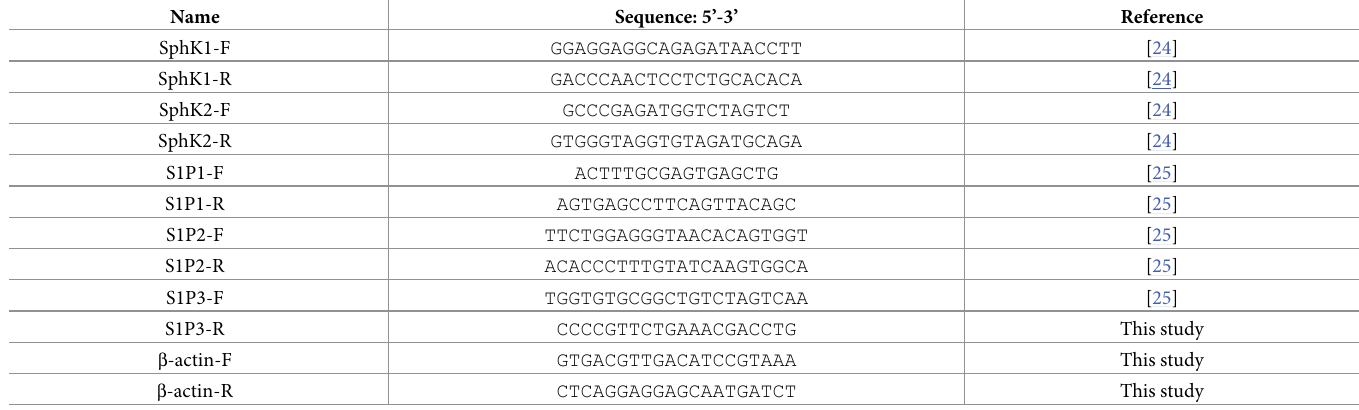
Table 2. Primer used in this